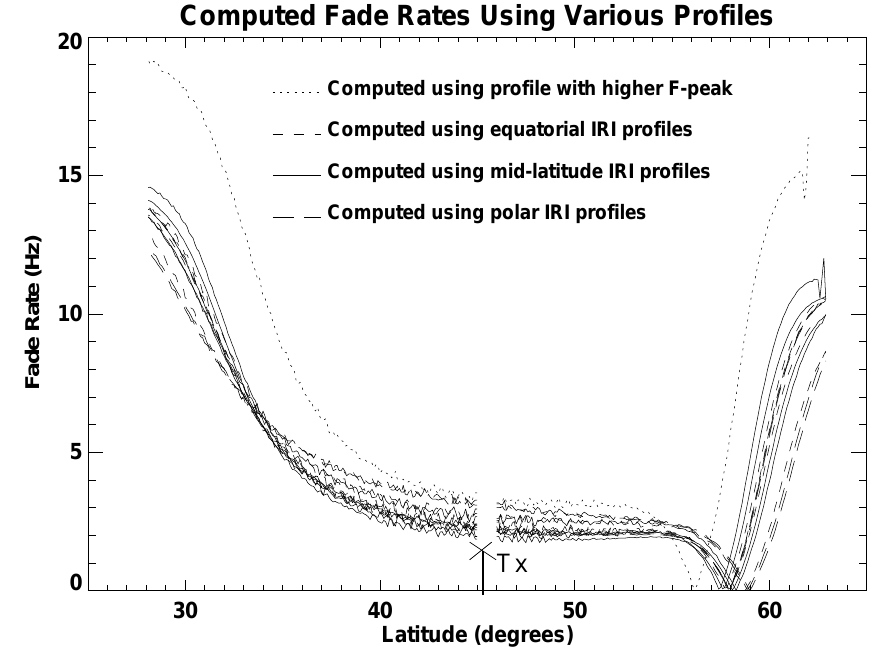
Fig. 7. The simulated Faraday fade rate as a function of satellite latitude using each electron density profile listed in Table 1. All the results for profiles with the same fo F2 value essentially coincide with one another and as such are essentially indistinguishable in the plot. Results show slightly higher fade rate values for profiles with higher TEC above the transmitter. Away from the transmitter, profiles with the same fo F2 peak produce similar values, but the profile with a higher peak results in much higher fade rates. Also, notice that the Faraday fade rate values drop to zero around 55 ◦ to 60 ◦ latitude. This is a consequence of the Faraday rotation the satellite observes at this location changing rotation directions. As a result the Faraday fade rate drops to zero as the polarization state switches from rotating in one direction to the